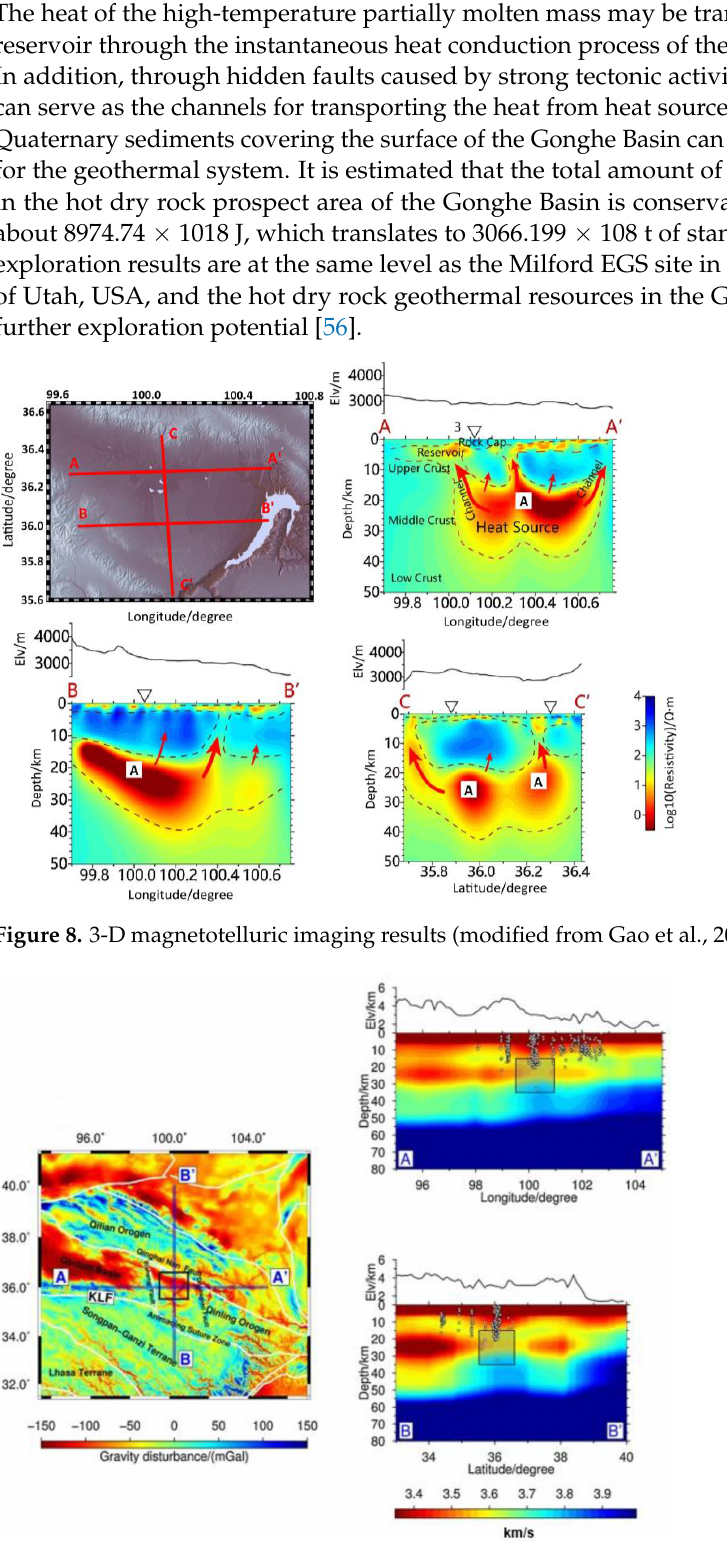
Figure 9. Linear inversion of Rayleigh wave group and phase velocity maps (Gao et al., 2018